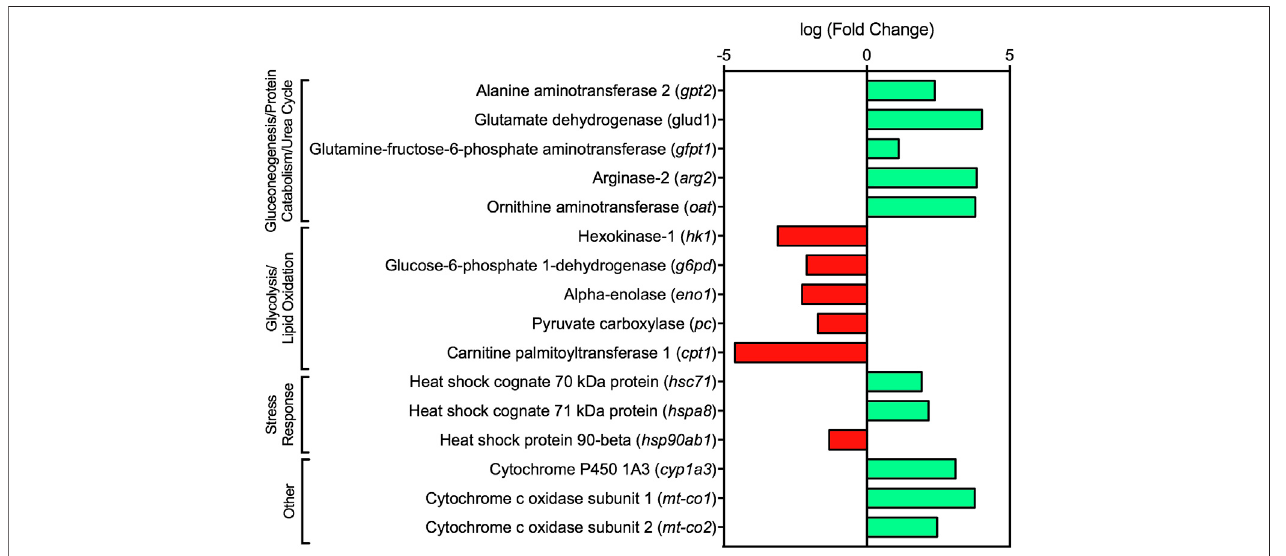
FIGURE 5 | Fold change of select transcripts dysregulated in dilbit-exposed lake charr relating to energy metabolism and stress response from RNA sequencing results. All transcripts were signi fi cant at FDR adjusted p -value ≤ 0.05, except cyp1a3 which was signi fi cant at a FDR adjusted p -value ≤ 0.1.